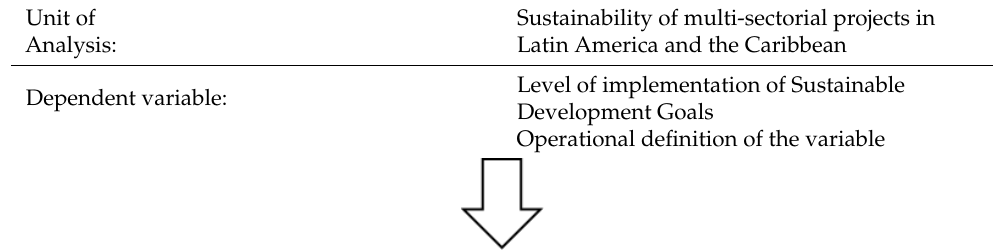
Table 6. Research